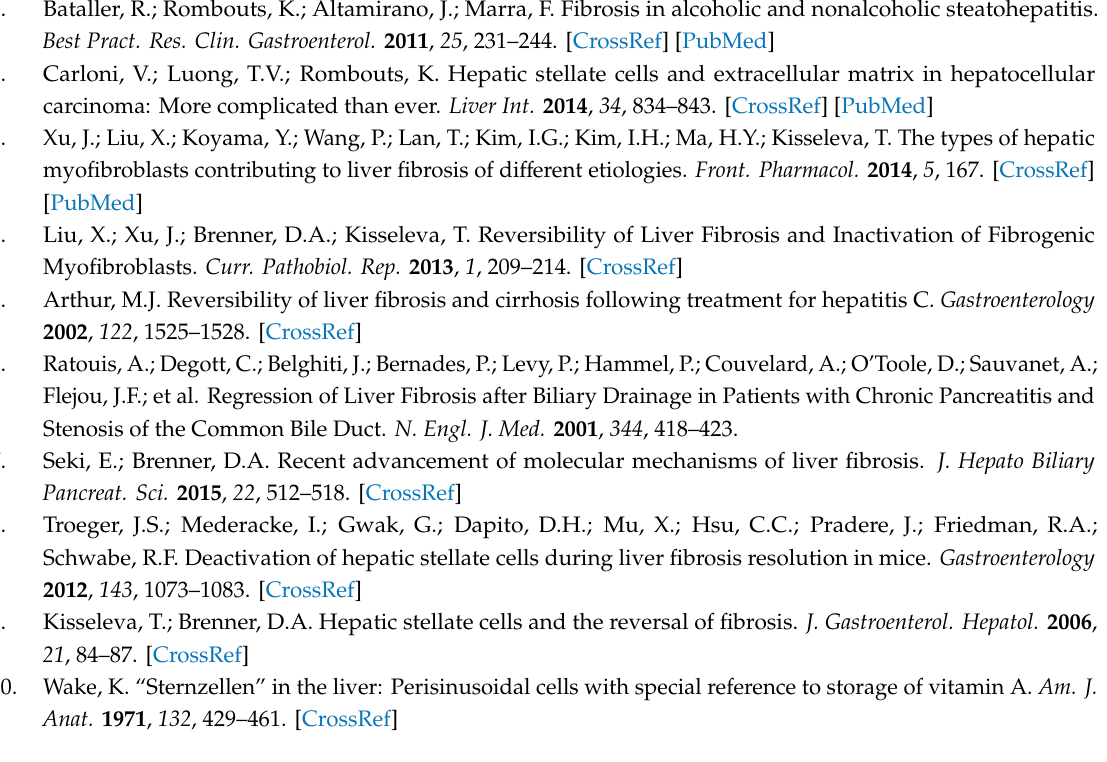
Figure S1: TGF- β 1 e ff ect on gene expression and of SMAD2 and SMAD3 phosphorylation levels; http: // www.mdpi. com / 2073-4409 / 8 / 11 / 1409 / s2, Figure S2: NV556 e ff ect on gene expression and protein secretion in a 3D human liver model reseeded with LX2 cells; http: // www.mdpi.com / 2073-4409 / 8 / 11 / 1409 / s3, Figure S3: NV556 e ff ect on gene expression and α -SMA positive area in the STAM